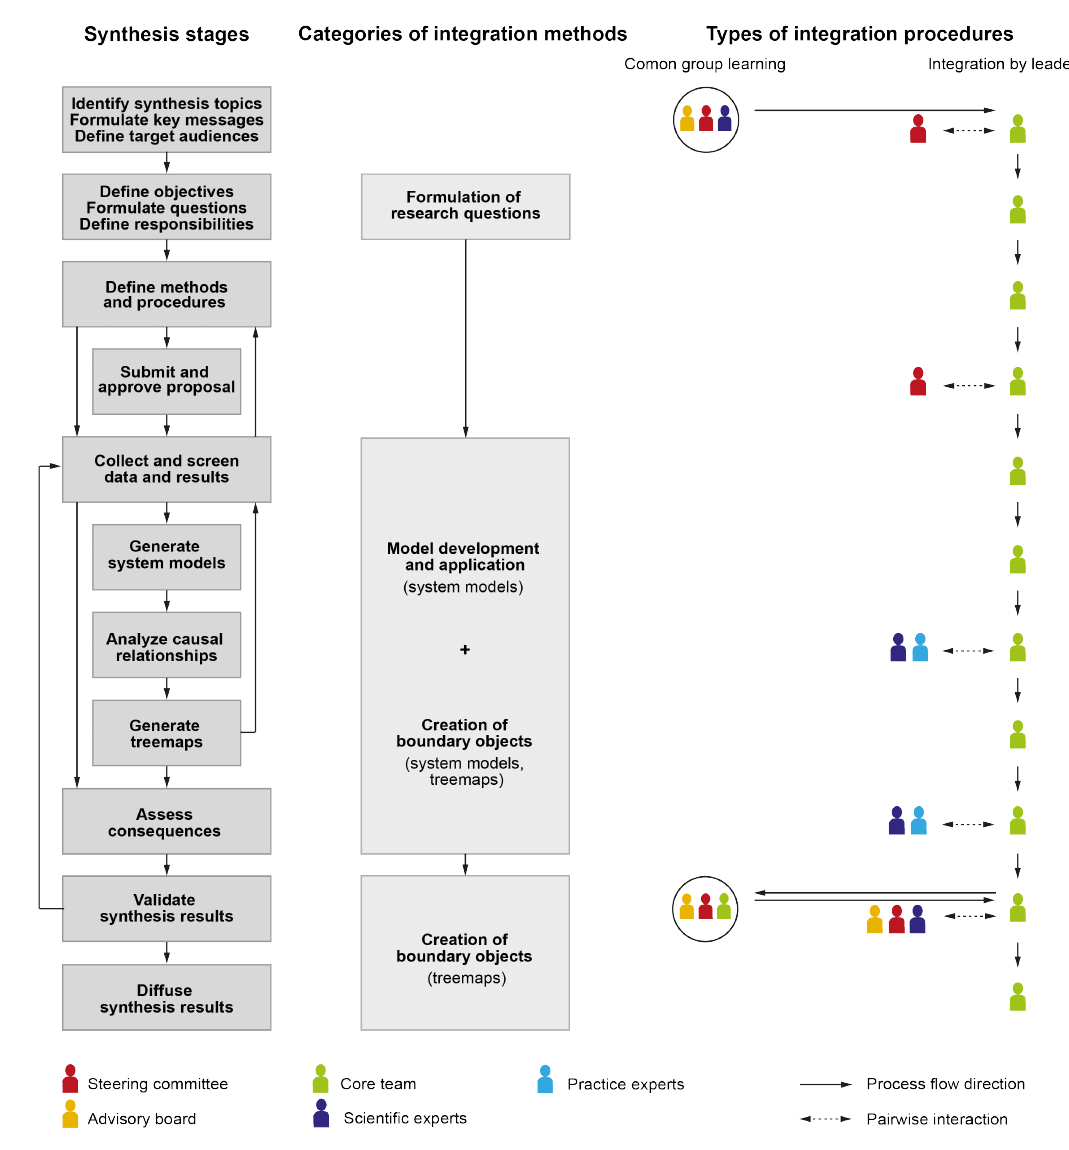
Fig. A3.1: Overall integration strategy of thematic synthesis 1 differentiated by synthesis stages, categories of integration methods, and types of integration procedures. The composition of the steering committee and the advisory board are described in the main text. The core team involved researchers from environmental sciences, environmental physics, hydrology, economics, and social sciences (n=3); scientific experts comprised scientists from economics, law, political science, hydrology, snow hydrology, landscape dynamics, hydrogeology, forest dynamics, biology, aquatic ecology, and water chemistry (n=18); practice experts represented the federal office for the environment, cantonal authorities, NGOs, and trade associations